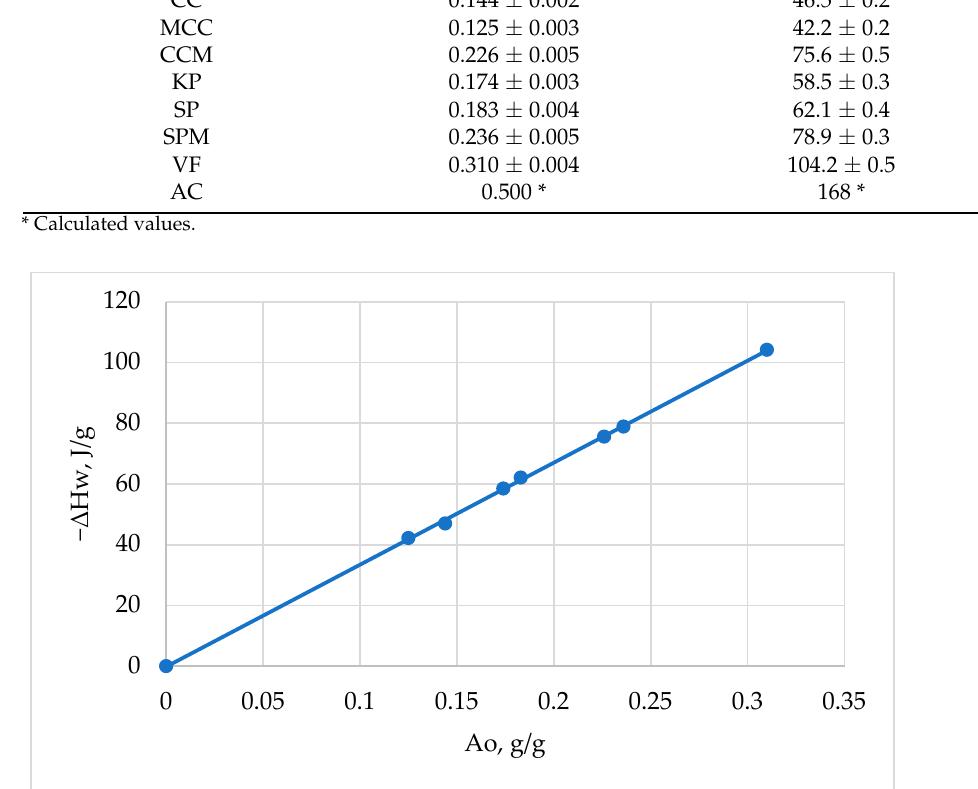
Figure 5. Dependence of wetting enthalpy on maximum moisture absorption value for various cellulose samples.